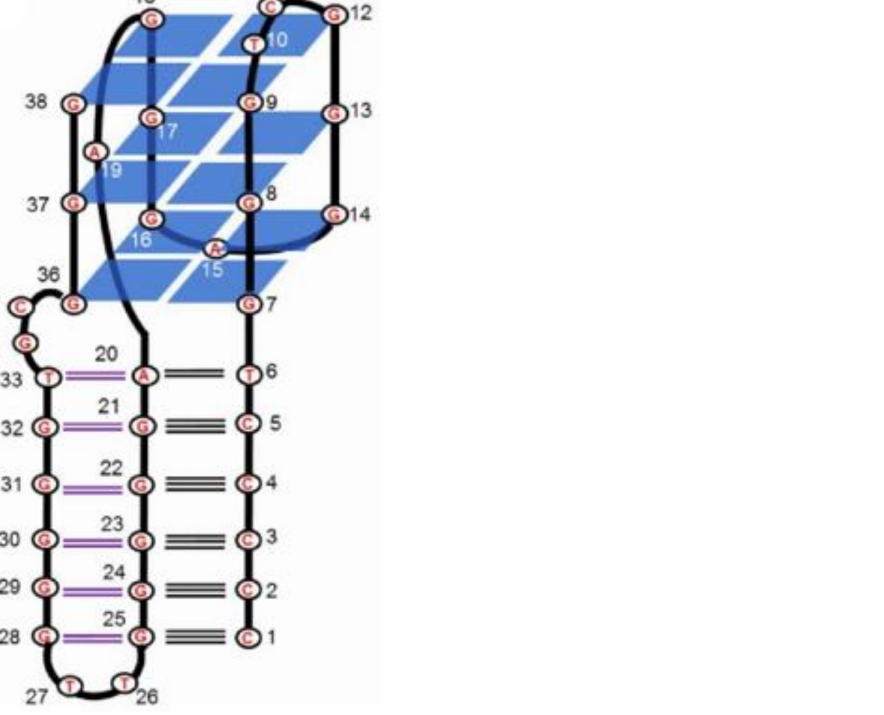
Figure 19. Schematic structure of CBA-1 [70]. Reproduced under the Creative Commons Attribution